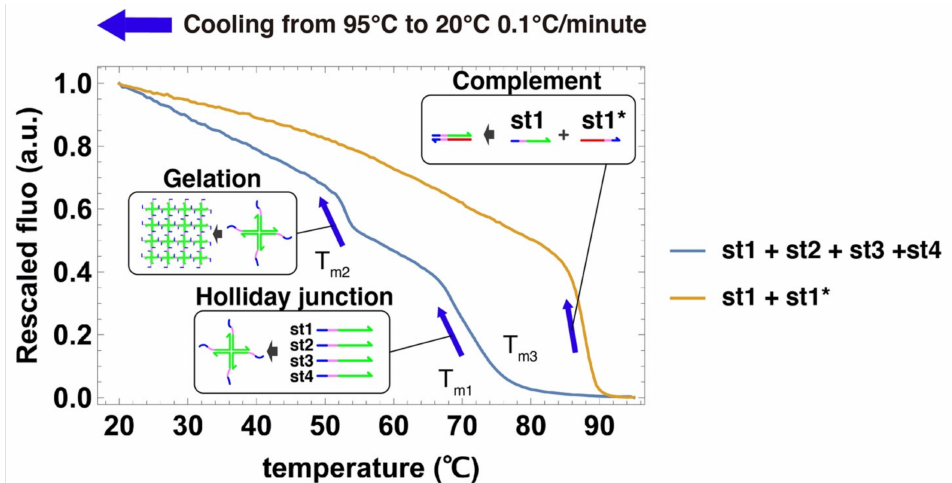
Figure 4. Cooling curves of the components of the DNA gels. DNA strands are mixed in a PCR tube, heated at high temperature, then slowly cooled down. Their hybridization is followed with a DNA intercalant by EvaGreen fluorescence (excitation wavelength is 450–495 nm and emission wavelength is 515–530 nm), which reports on the number of base pairs formed. The blue curve shows the cooling curve of a solution containing all the strands composing the DNA hydrogel. The yellow curve shows the cooling curve of strands st1 and st1*. All strands are present at 100 µ M